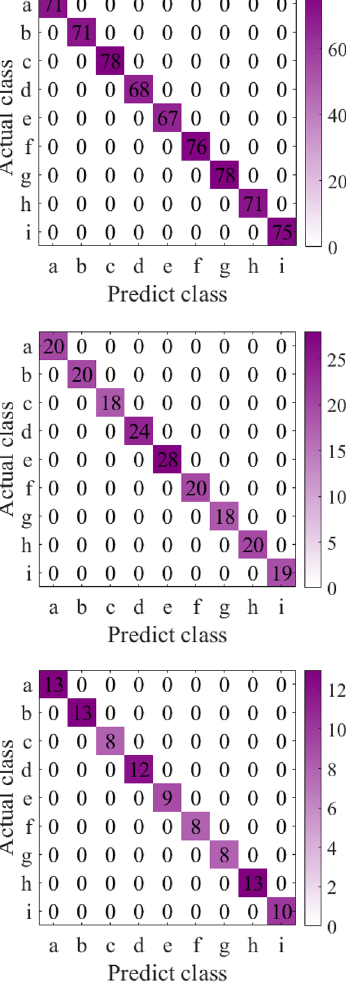
Fig. 10. The precision of literature 35, literature 36, literature 37 and this method is 99.62%, 93.75%, 91.96% and 100% respectively (Five experiments were carried out and averaged). The identification accuracy of the method in this paper is 0.48% higher than that of reference 35, and more than 6% higher than that of the other two litera- ture methods. It can be seen that the method in this paper has certain advantages over the other three methods. In order to further reflect the advantages of the proposed method, a comparison test was conducted between the proposed method and other conventional methods. The experimental data are still used from the well-known Case Western Reserve University bearing fault dataset, and the details of the data are shown in Table 1 for the statistical properties of the Case Western Reserve University bearing fault dataset. We conducted comparative experiments using Support Vector Machines (SVM), Long Short-Term Memory (LMST), One-Dimensional Convolutional Neural Networks (1D-CNN) and Extreme Gradient Boosting (XGBoost) respectively. To make the results more convincing, we made the structure of the 1D-CNN consistent with that of the feature extractor. The parameters of the SVM were kept consistent with the classifier. The LMST used two LMST layers and one fully-connected layer, with the fully-connected layer as the output layer. The average recognition accuracy on the test set is shown in Table 2. It can be seen from Table 2 that except for the methods we proposed, the identification accuracy of other methods is not very high. The highest recognition accuracy among the remaining four methods was 42.22% and the lowest was 22.22%. Among them, SVM and XGBoost are both traditional machine learning methods. Although they have certain advantages in processing small sample data, their feature extraction ability is weak, resulting in low recognition accuracy, which often requires manual extraction of features before using them for classification and recognition. In contrast, 1D-CNN and LSTM belong to deep learning methods. Although they have strong feature extraction capability, their low recognition accuracy is due to the small sample size and the under-learning of model parameters.